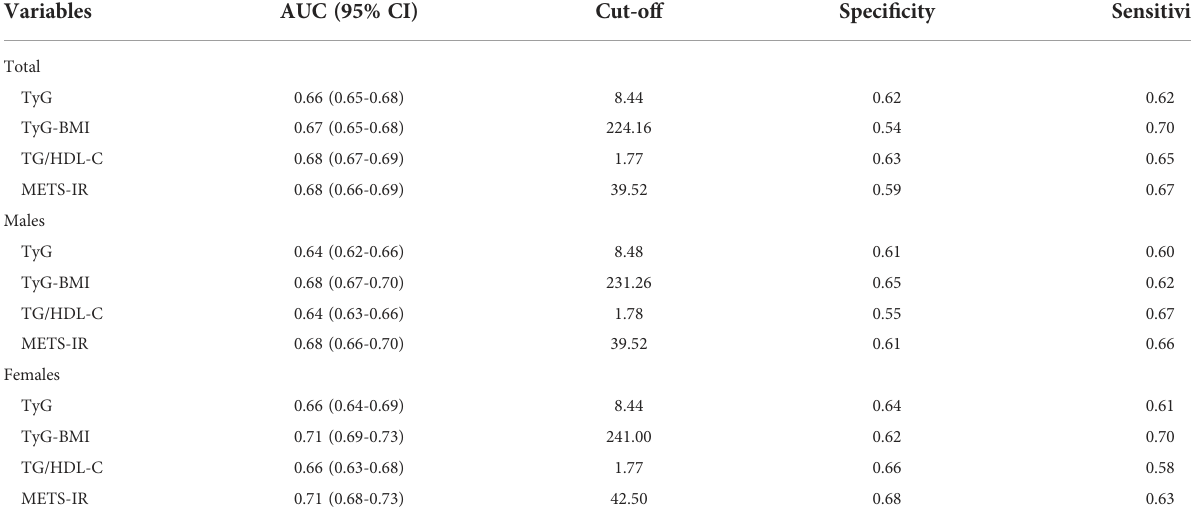
TABLE 3 AUC and cut-off values of four IR surrogates for prediction of HU.